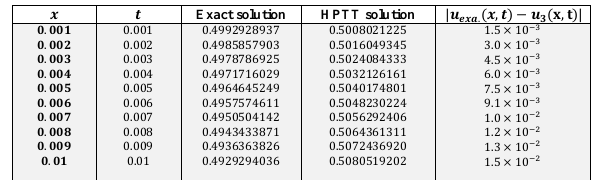
Table 3: Absolute errors for differences between the exact solution and 3 rd order HPTT solution for diverse values x and t when ρ = −1, β = 1 , for Ex.